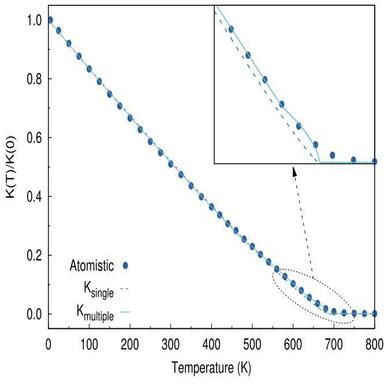
Comparison of the fit achieved via the standard (single) and extended (multiple) Callen-Callen methods. The points represent the atomistic simulation data while the lines show the fits used in MARS. The extended Callen-Callen is able to provide an improved fit overall and especially near the Curie point as shown in the inset.